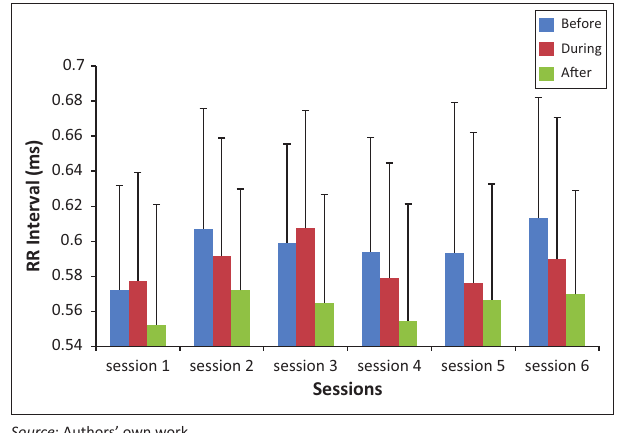
FIGURE 1: R-R interval before, during and after therapeutic horseback riding (THR) over six sessions.